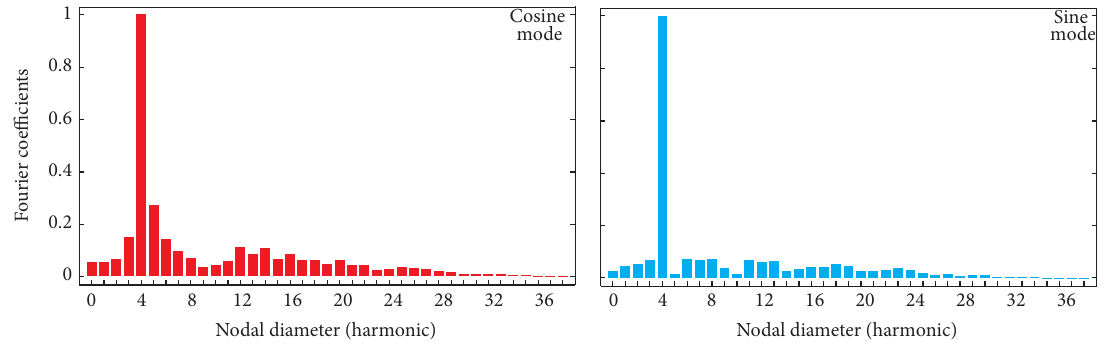
Figure 17: (a) Distribution of the Fourier coefficients of the spatial decomposition of the sine and cosine drum-dominated modes D4 with 𝑛 = 4 diameters.